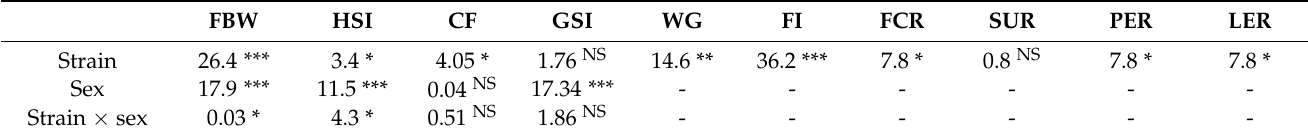
Table 5. Experiment 2 in Kinshasa, western lowlands DR Congo— F -value ( p -value) of fixed effects for final body weight (FBW), condition factor (CF), hepato-somatic index (HSI), gonado-somatic index (GSI), initial body weight (IBW), weight gain (WG), feed intake (FI), feed conversion ratio (FCR), survival (%) (SUR), protein efficiency ratio (PER), and lipid efficiency ratio (LER). FBW,